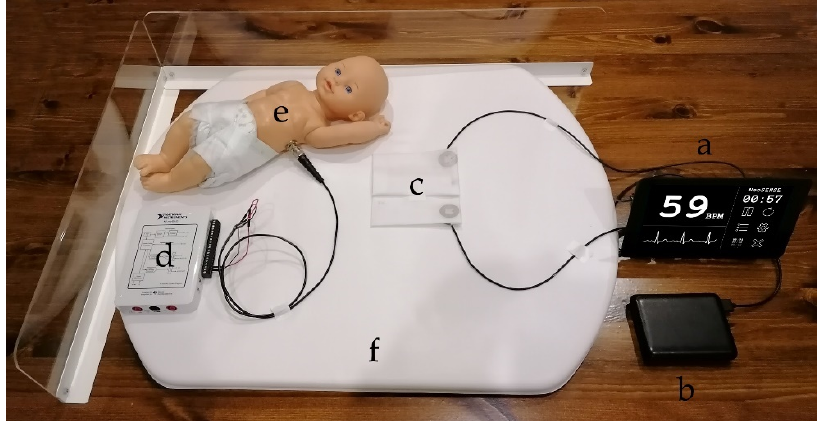
Figure 10. Photograph of prototype system hardware in neonate simulation environment: (a) front end and GUI (Dimensions 195 × 100 × 90mm); (b) USB 5V power bank; (c) EPS sensors and textile based electrodes; (d) digital to analogue converter for test signal generation; (e) neonate mannequin with internal antenna; (f) commercial delivery room mattress.